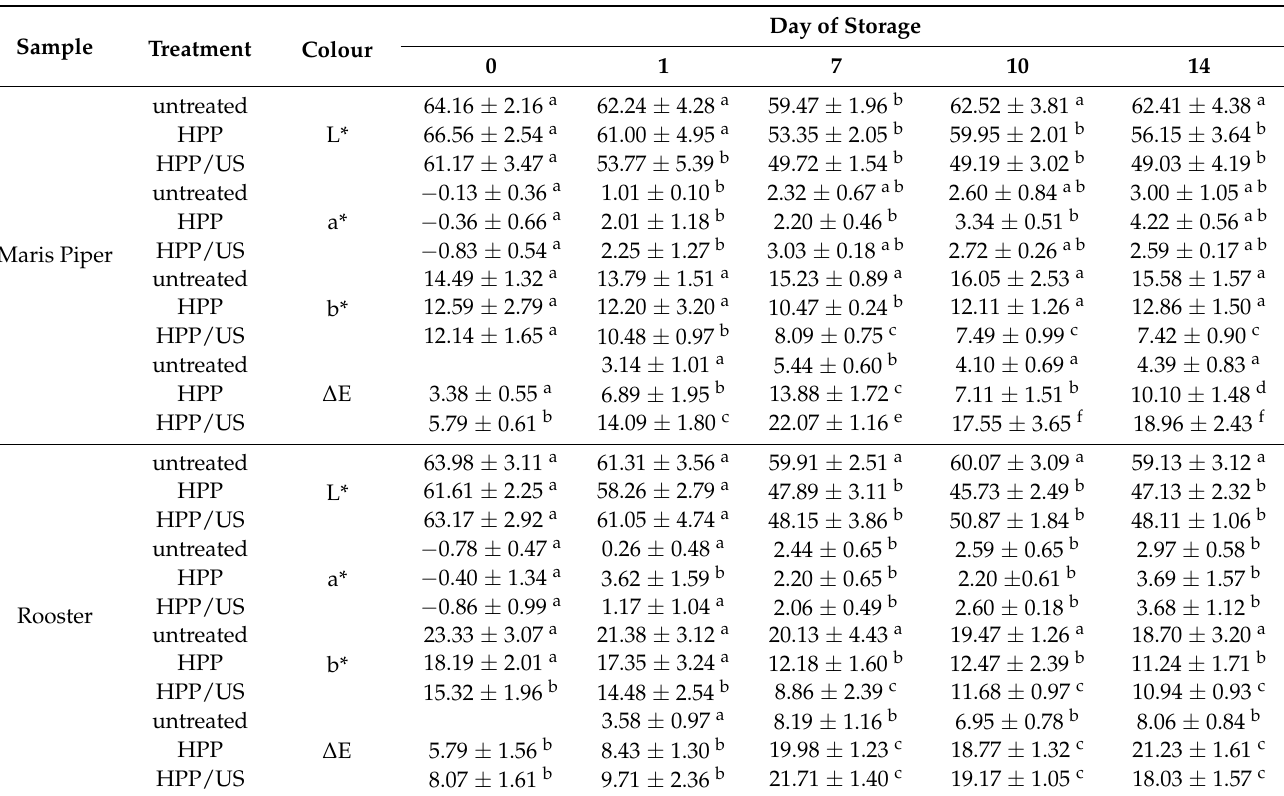
Table 1. Values of colour parameters in untreated (controls), HPP- and HPP/US-treated minimally processed potatoes of the Maris Piper and Rooster